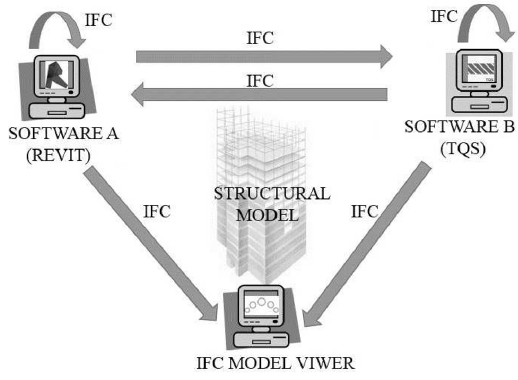
Fig. 6. Model transfers